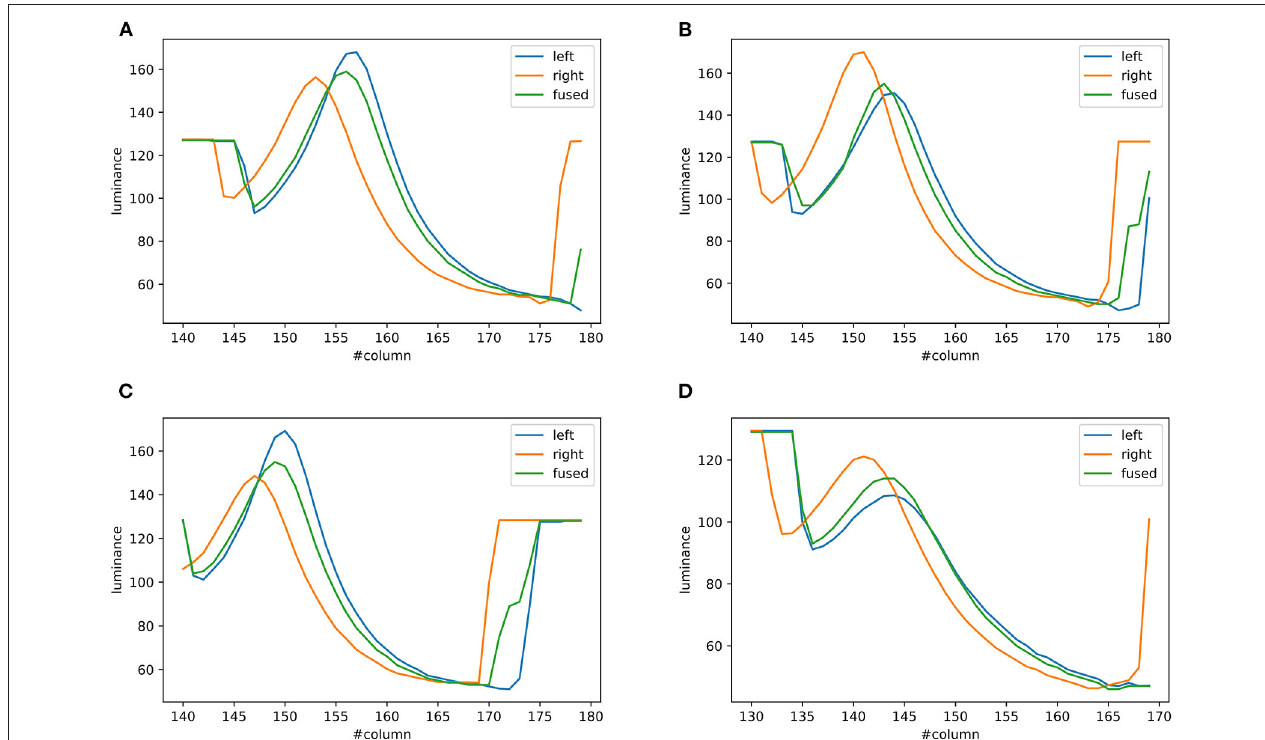
FIGURE 8 | Examples of binocular combination. The four (A–D) show the luminance profiles of a single row where the four black spheres in Figure 7 are located, respectively. Each figure shows the luminance profiles from the left retina, the right retina and the fused map.